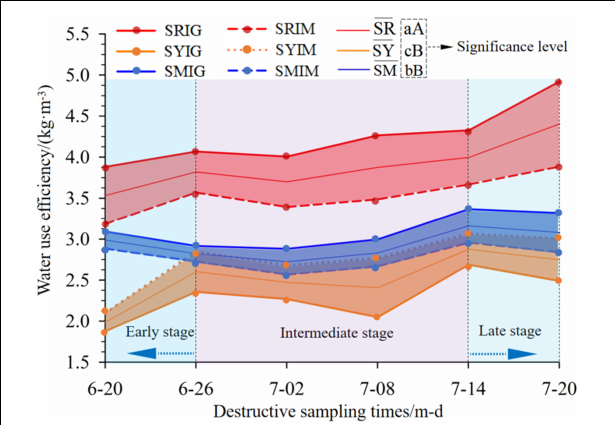
FIGURE 7 | Dynamic plot of WUE under six destructive samplings during the whole growth cycle of pepper. SR, SY, and SM represent the mean lines of water-use efficiency under two irrigation methods in red soil, yellow sandy soil, and mixed soil in Yunnan, respectively. Letters indicate significance levels; different lowercase letters (a, b, c) in the same column indicate significant differences ( p < 0.05), whereas different capital letters (A, B) in the same column indicate highly significant differences ( p < 0.01). The meaning of the “treatment condition codes SRIG, SRIM, SYIG, SYIM, SMIG and SMIM” is detailed in the notes with Figure 5